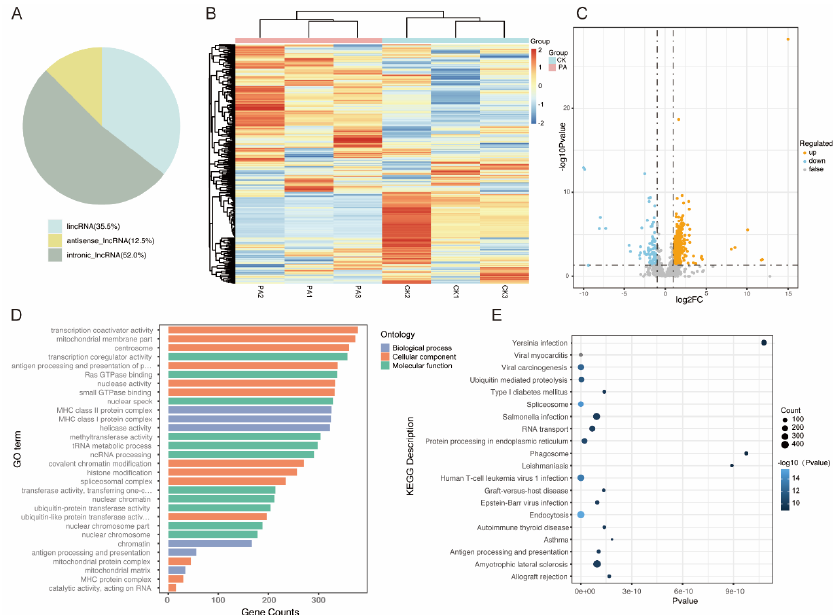
Figure 2. Identification of differentially expressed lncRNAs (DELs) between peanut allergy and control groups. ( A ) Classification and proportion of identified lncRNAs. ( B ) Hierarchical clustering for distinguishable lncRNA expression profiling among groups. ( C ) Volcano plot of all DELs between PA individuals (N = 3) and healthy controls (N = 3). ( D , E ) GO ( D ) and KEGG ( E ) enrichment pathway analysis involving DELs.